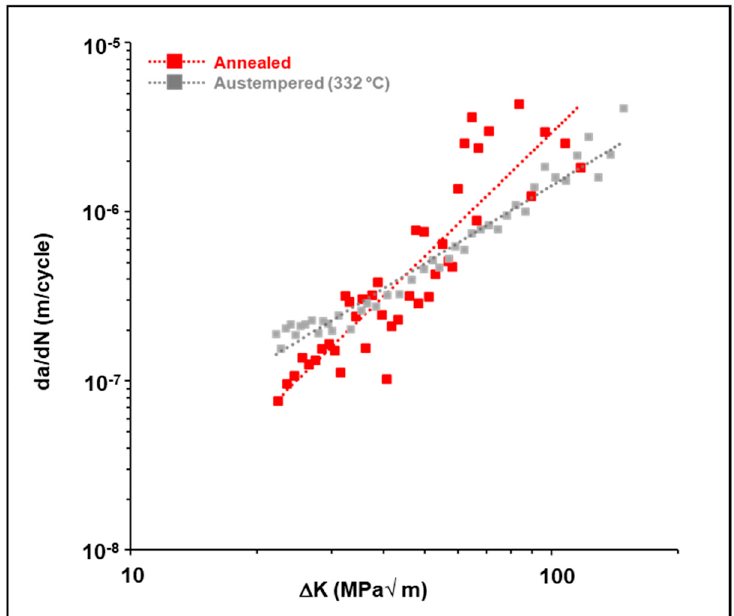
Figure 9. The Effect of Austempering on the Fatigue Crack Growth Rate of the 4140 Steel Hydrogen-Charged for 150 h.